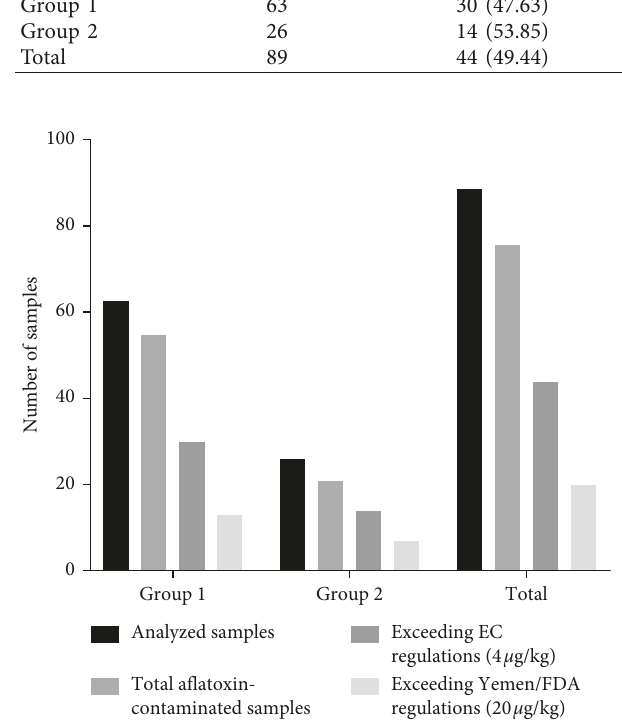
Figure 3: Total aflatoxin contamination in groundnut samples (total samples, group 1, and group 2).